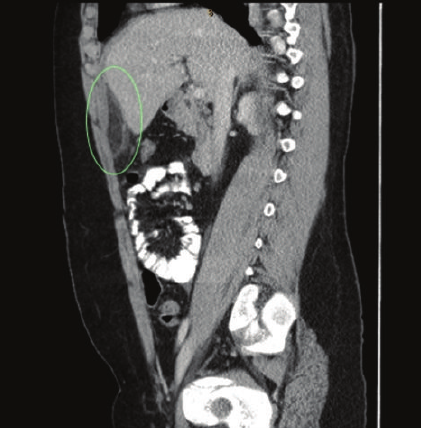
Figure 1: CT abdomen and pelvis-sagittal view. Torsion of lipoma- tous appendage of falciform ligament circled.